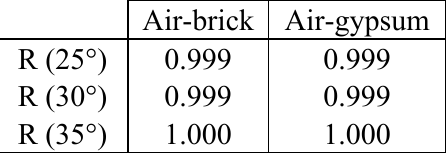
Table 2. Values of the reflection coefficient for three differents angles. The angle of the sensors with the normal of the test specimen surface are 30